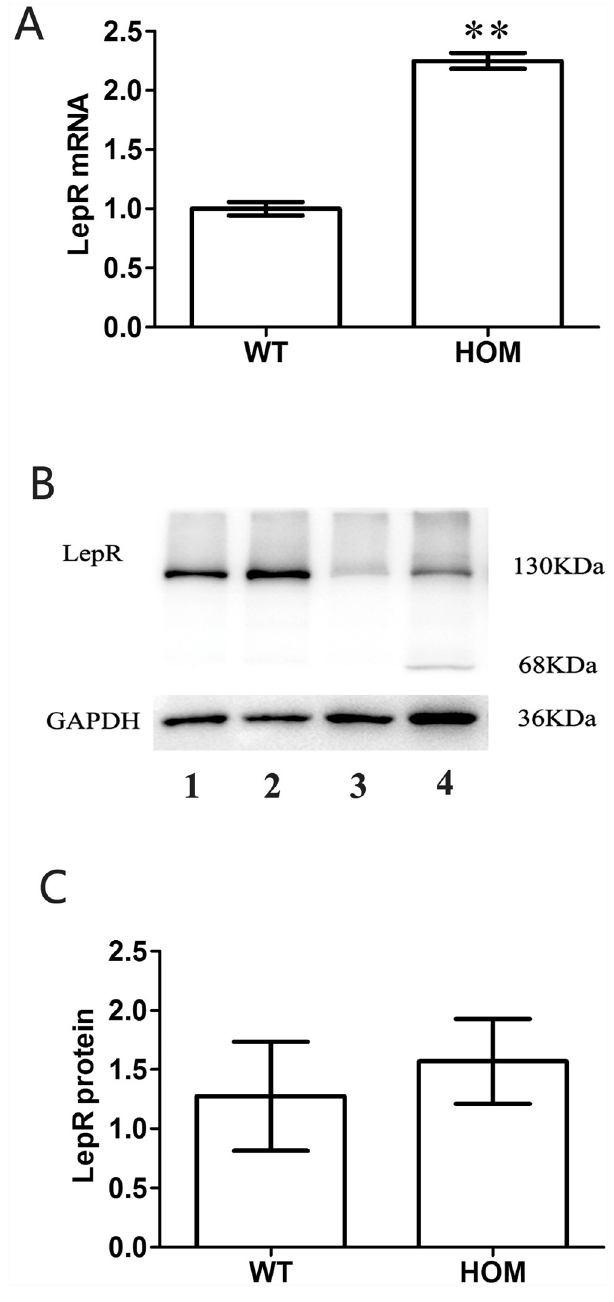
Fig 3. Detection of LepR mRNA and protein levels in ovarian tissue extracts of LepR Y123F mutated Homozygous (HOM) and wild mice (WT). Panel A, Relative ovarian mRNA expressions of LepR in HOM and WT ovaries (n = 3). All data were normalized by WT, and bar values are presented as mean ± SD. ** p < 0.01. The mRNA expression level of LepR in HOM ovaries was significantly higher than in WT ovaries. Panel B. LepR protein expression level detection by western blotting. Upper row is LepR, and the lower row is the internal control of GAPDH. Lanes 1 and 2 were loaded with ovary samples of WT and HOM, respectively; and lanes 3 and 4 with kidney and brain samples. Panel C. Densitometric analysis of western blotting detection of LepR. Data are represented as mean ± SD of measurements from four independent experiments. No statistical difference was